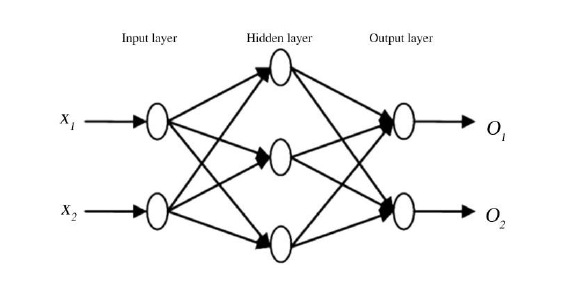
Fig. 1 Feedforward neural network with three-layer